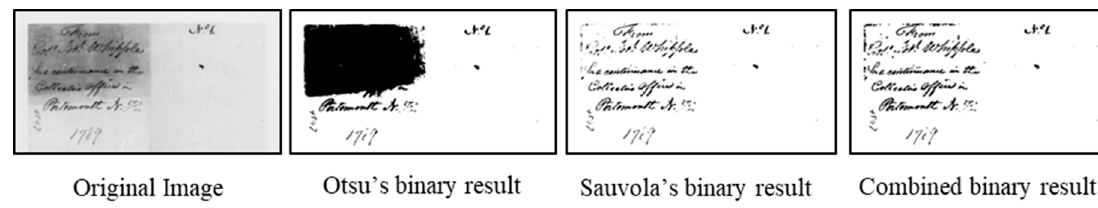
Figure 14. Example showing results obtained from Otsu and combined binary approach.